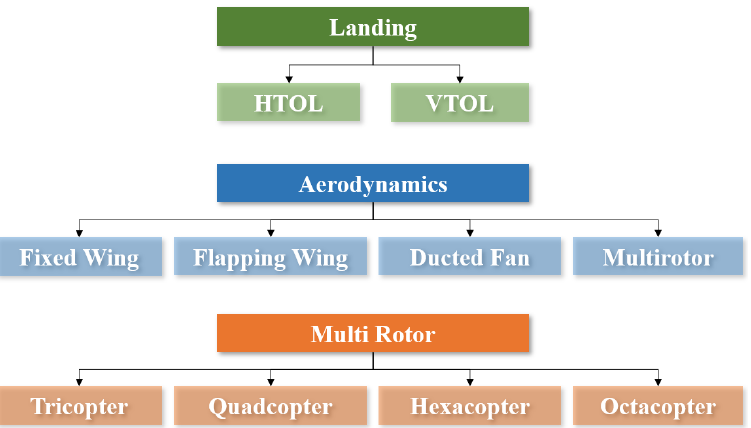
Figure 2. Classification of UAVs according to landing, aerodynamics, and multirotor [34].